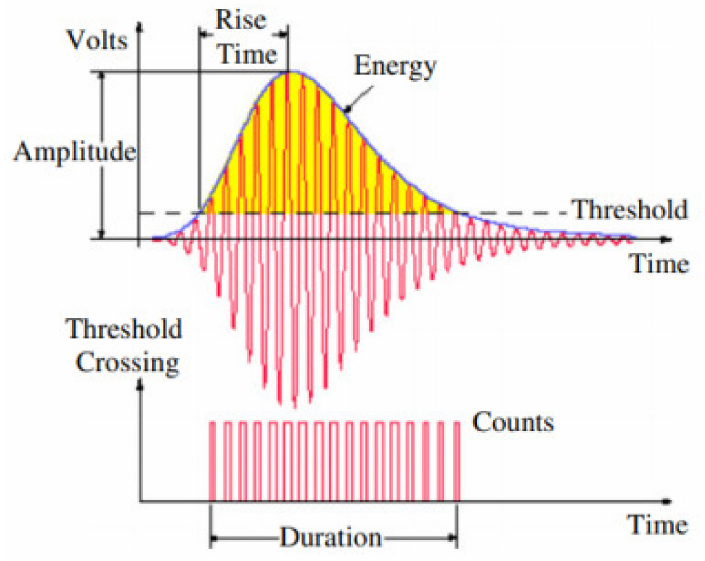
Figure 2. A typical AE signal